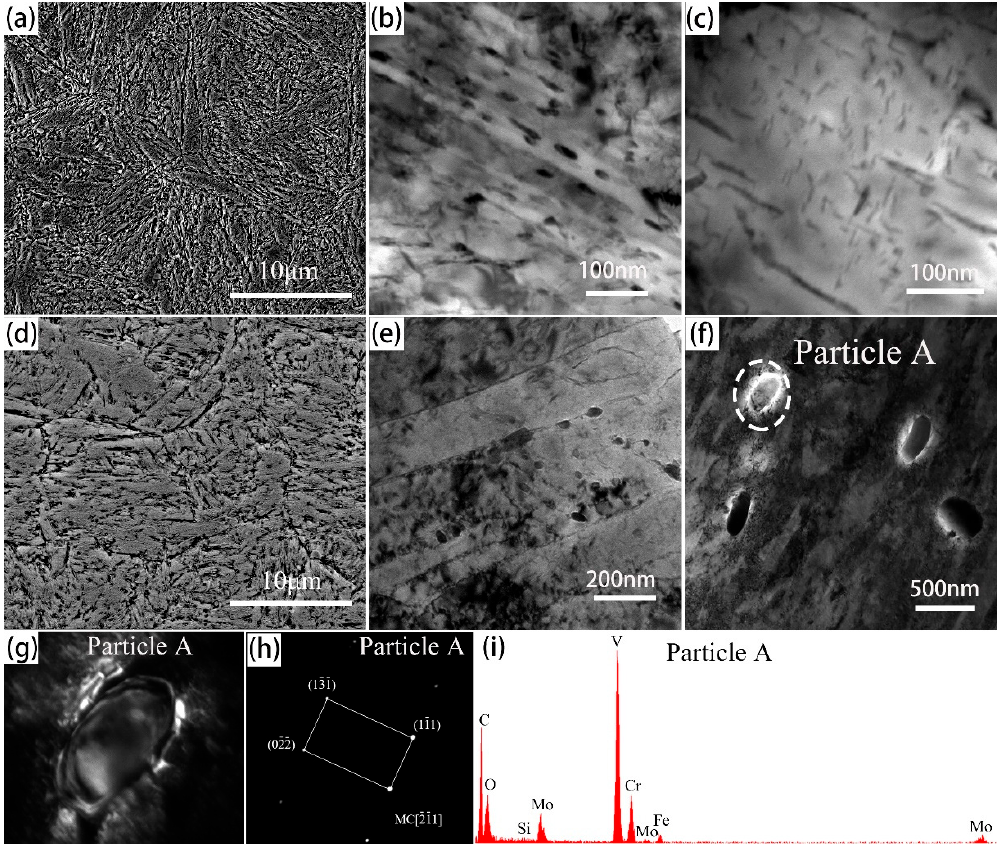
Figure 7. Microstructure of both steel alloys prior to additional tempering: ( a ) microstructure of the 5Cr5Mo2 steel observed by SEM; ( b ) elliptical-shaped secondary carbides and ( c ) fine needle-shaped secondary carbides of the 5Cr5Mo2 steel observed by TEM; ( d ) microstructure of the H13 steel observed by SEM; ( e ) secondary carbides and ( f ) large-size primary carbides of the H13 steel observed by TEM; ( g ) morphology, ( h ) di ff raction, and ( i ) energy spectra of particle